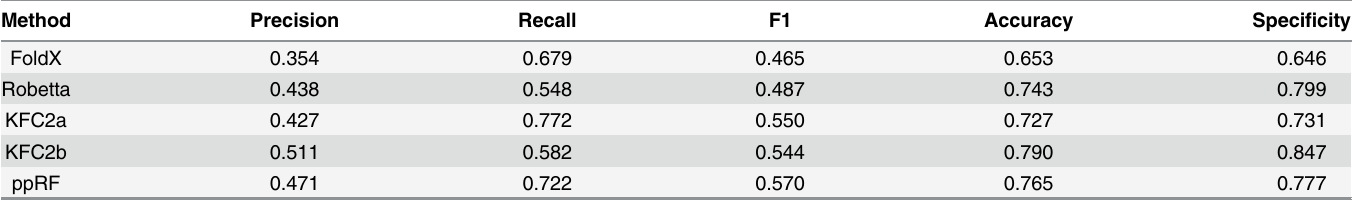
Table 2. Performance comparison between FoldX, Robetta, KFC2 and ppRF on the ASEdb dataset. The performance of ppRF is evaluated using leave-complex-out cross-validation. FoldX, Robetta and ppRF are able to produce numerical values of ΔΔ G p . A predicted binding hot spot for these three methods is defined using ΔΔ G p (cid:1)